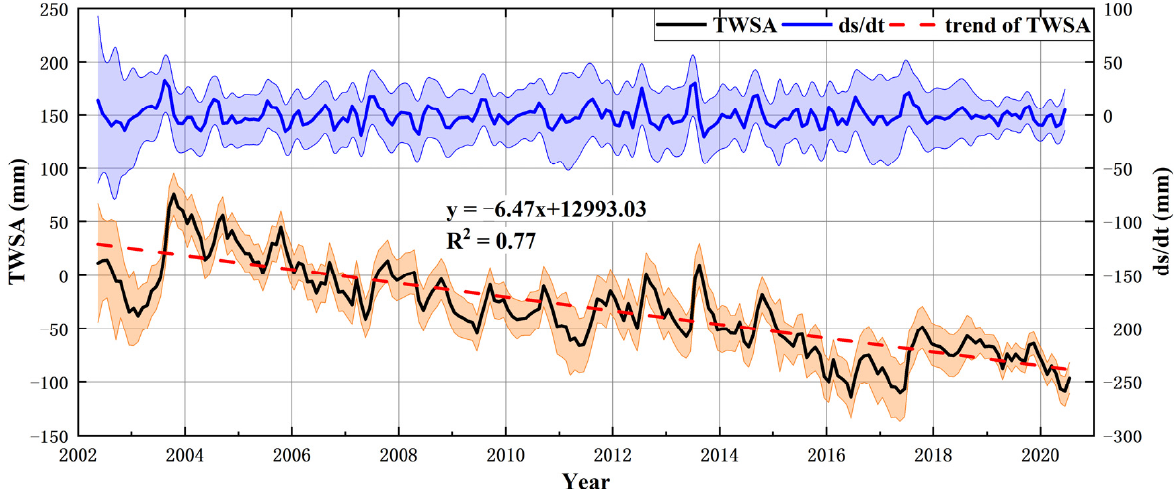
Figure 2. Time series of terrestrial water flux and terrestrial water storage anomaly in the Yellow River Basin. The light blue and light green shaded parts represent uncertainty for the ds/dt and TWSA, respectively.